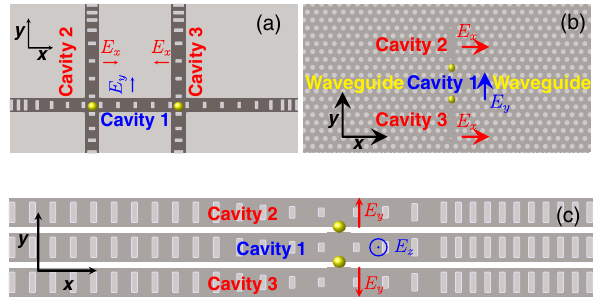
FIG. 7. Possible construction of multiport optical routers. (a) Realization using nanobeam cavities. (b) Realization using PC cavities. (c) Realization using side-by-side layout